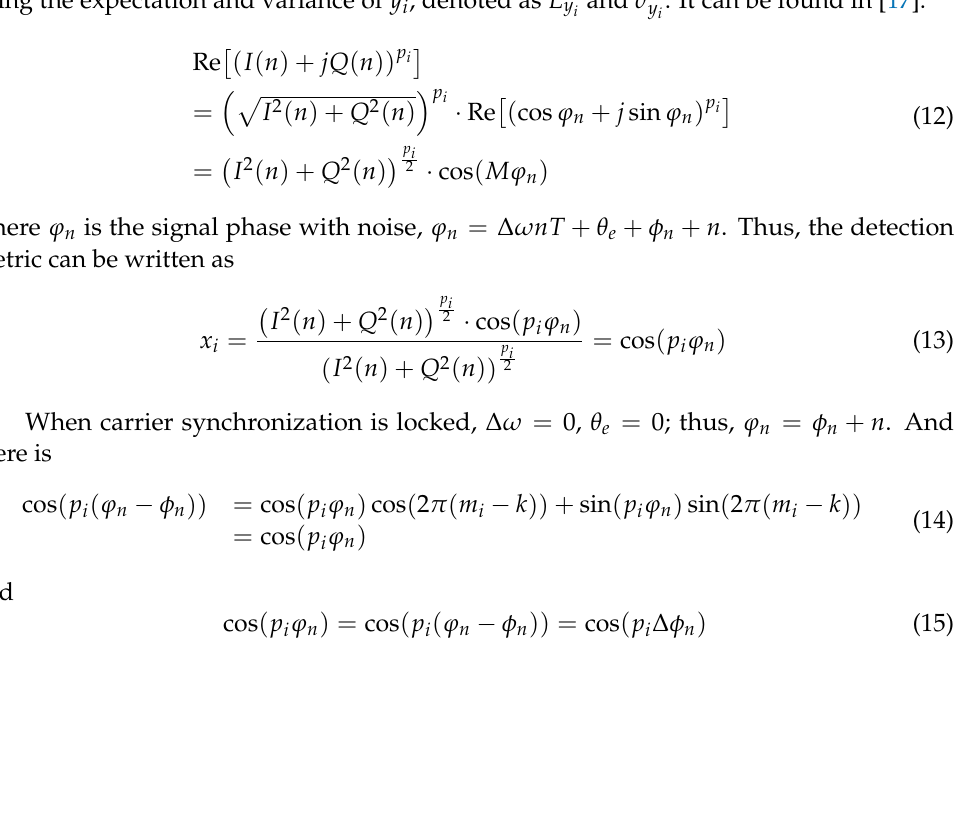
Figure 3. Diagrammatic sketch of ring judgment for 32APSK signals.